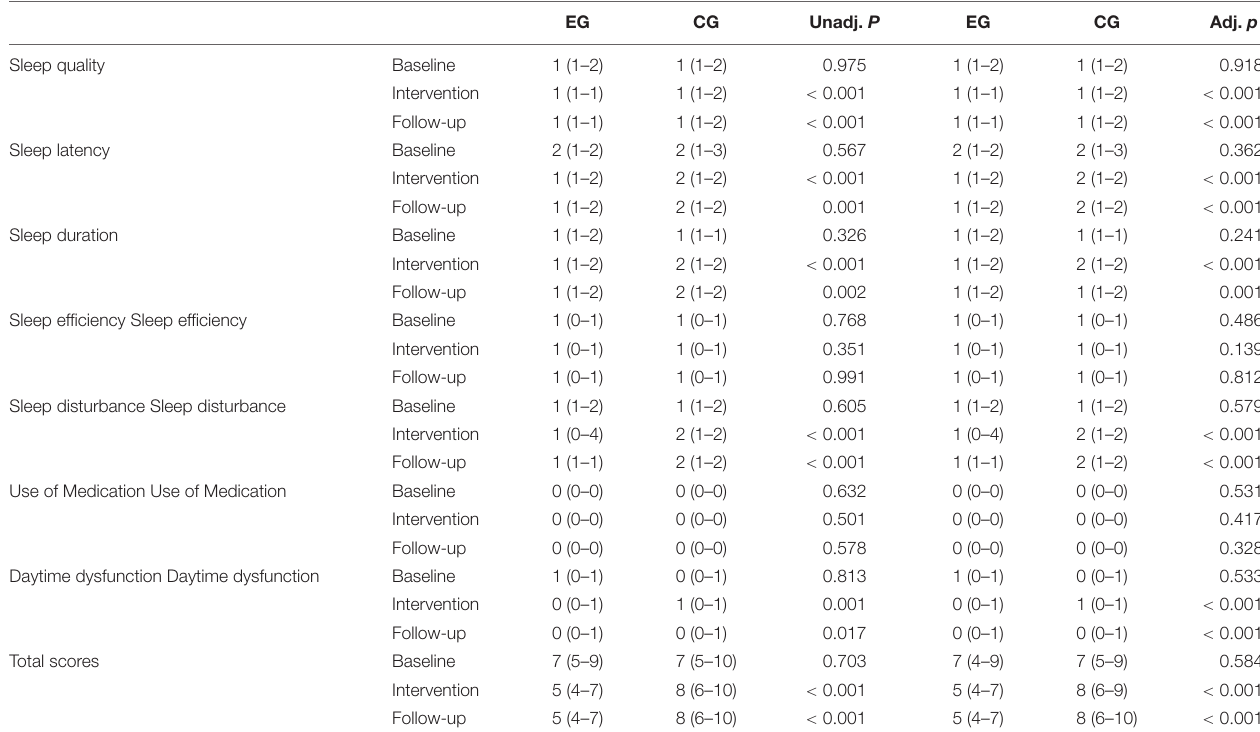
TABLE 4 | The effects of ESB on PSQI (Median,